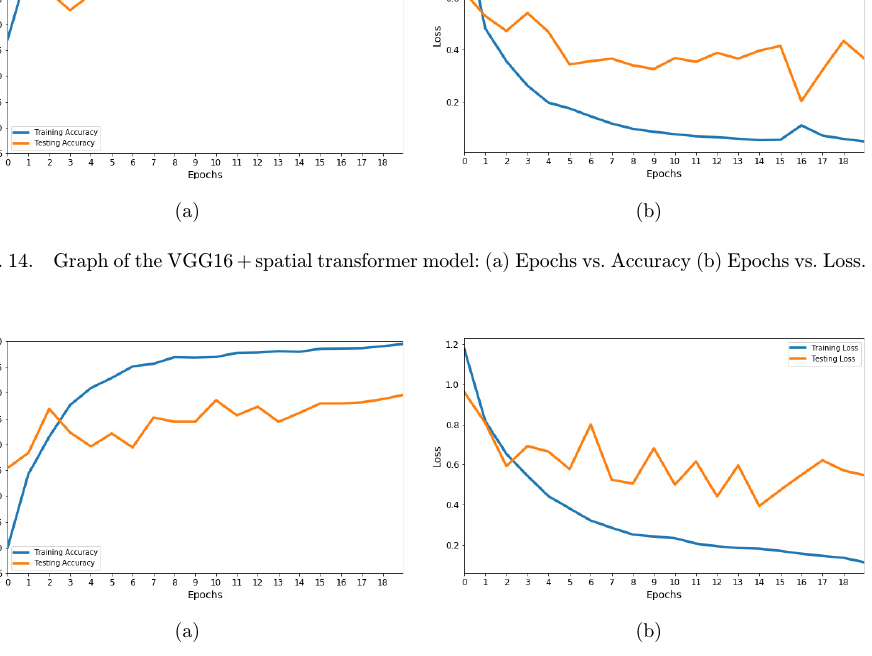
Fig. 15. Graph of the VGG19 þ spatial transformer model: (a) Epochs vs. Accuracy (b) Epochs vs. Loss.